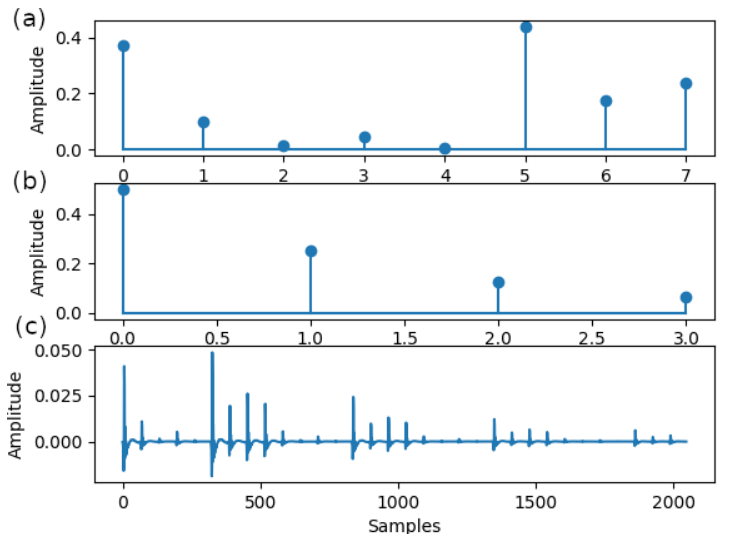
Figure 10. Impulse responses for the trilinear setup: ( a ) h 2 , random generated impulse response; ( b ) h 3 , exponential generated impulse response; and ( c ) Impulse response of the target system, h = h 3 ⊗ h 2 ⊗ h 1 .